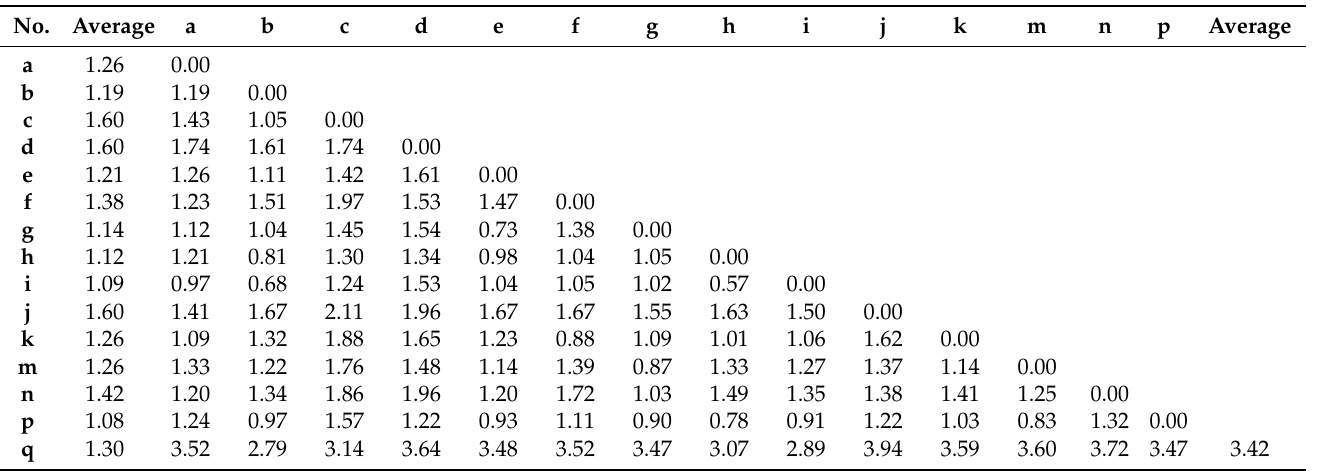
Table 5. Similarity between gardens.